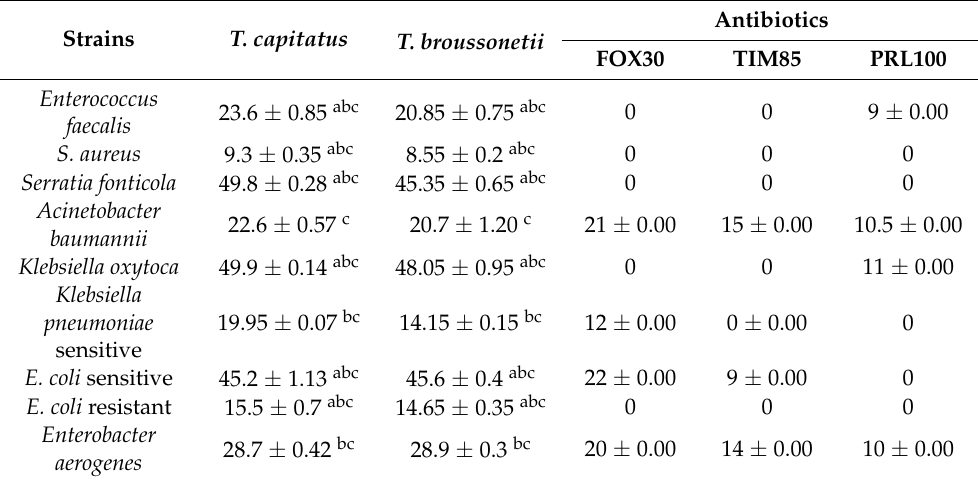
Table 2. Antibacterial activities of T. capitatus and T. broussonetii EOs and of antibiotics (FOX30, TIM85, PRL100) using the disk diffusion method